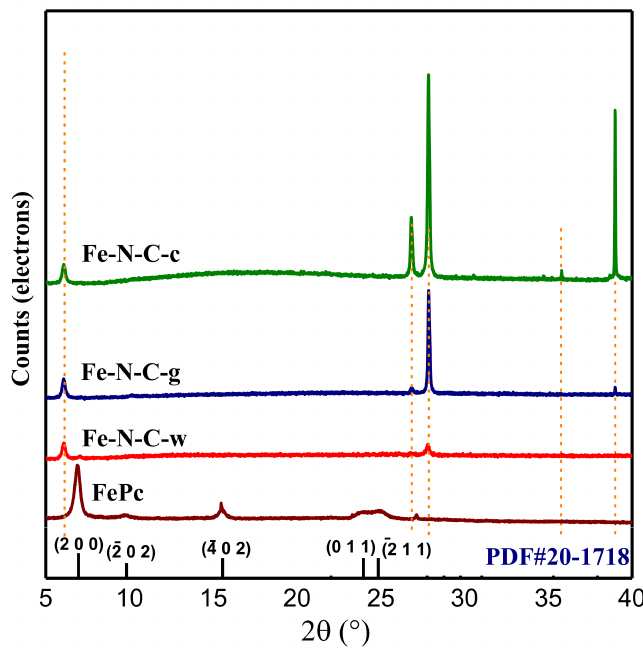
Figure 3. XRD patterns of FePc powder, as well as Fe–N–C-r, Fe–N–C-g, and Fe–N–C-f